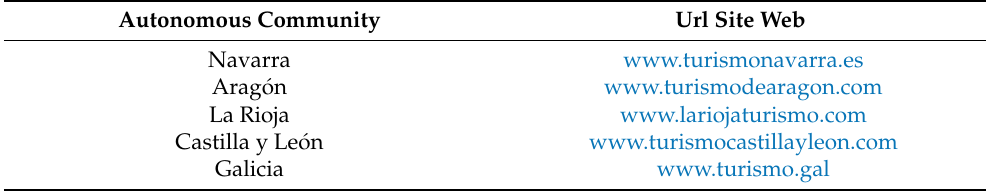
Table 1. Web sites of the ACs of the French Way of Saint James in Spain. Autonomous